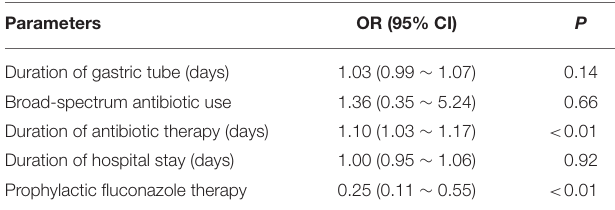
TABLE 3 | The risks of NCFI in the prophylaxis group relative to the rescue group in the multivariate logistic regression